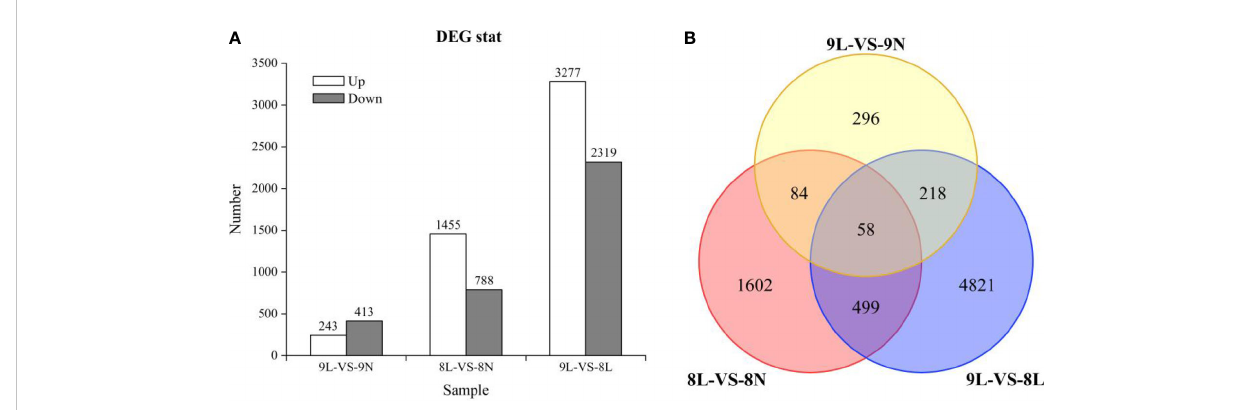
FIGURE 2 (A) The number of diferentially expressed genes in each comparison. (B) Venn diagram illustrating the genes of L. corniculatus in response to low-P stress.DEGs are shown in Venn diagrams. 9: Low-P-tolerant line 01549; 8: low-P-intolerant line 08518; L: low P; N: normal